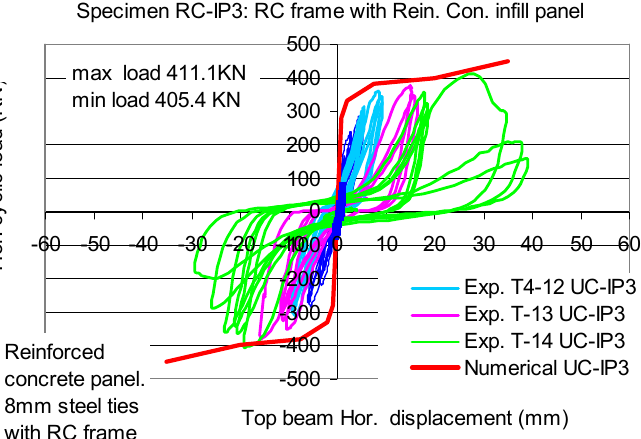
( b ) Figure 27. ( a ) The numerically predicted diagonal tension limit state for specimen RC ‐ IP 3. ( b ) The observed damage for specimen RC ‐ IP 3. Numerical Simulation of UC ‐ IP 1 : The previously described numerical methodology was first applied for specimen UC ‐ IP 1. The numerical response in terms of envelope curve of the horizontal load versus the horizontal displacement at the top beam is depicted in Figure 22, being compared with the corresponding measured experimental cyclic response. The predicted peak load horizontal value is equal to 135 kN and compares reasonably well with the peak measured value equal to 127 kN. The predicted shear strain versus horizontal load response distribution compares reasonably well with the corresponding measured response. The numerically predicted compressive limit state at the corners of the infill panel (Figure 23a) also compares well with the crushing of the corners, which was observed for this specimen during testing (Figure 23b). Numerical Simulation of UC ‐ IP 2 : The numerical response for specimen UC ‐ IP 2, in terms of envelope curve of the horizontal load versus the horizontal displacement at the top beam, is depicted in Figure 24. This numerical response is compared with the corresponding experimentally measured cyclic response. The predicted peak horizontal load value is equal to 350 kN and compares reasonably well with the corresponding measured value equal to 338 kN. The predicted shear strain versus horizontal load response distribution compares